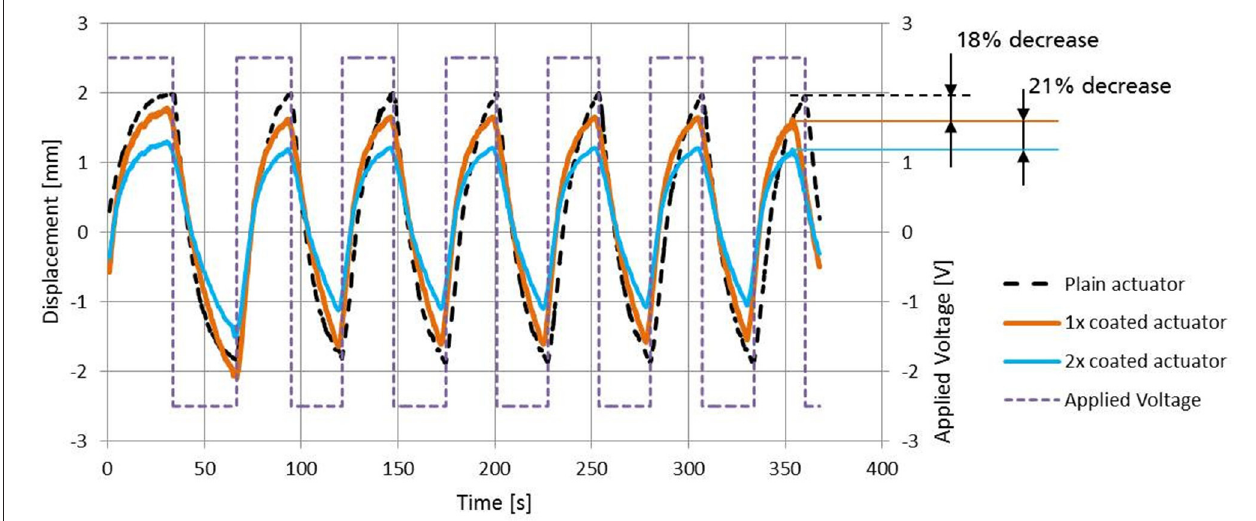
FIGURE 5 | Impact of thin dip-coated PVDF encapsulation layers on actuator displacement. Actuator size: 20 × 8 × 0.2 mm.